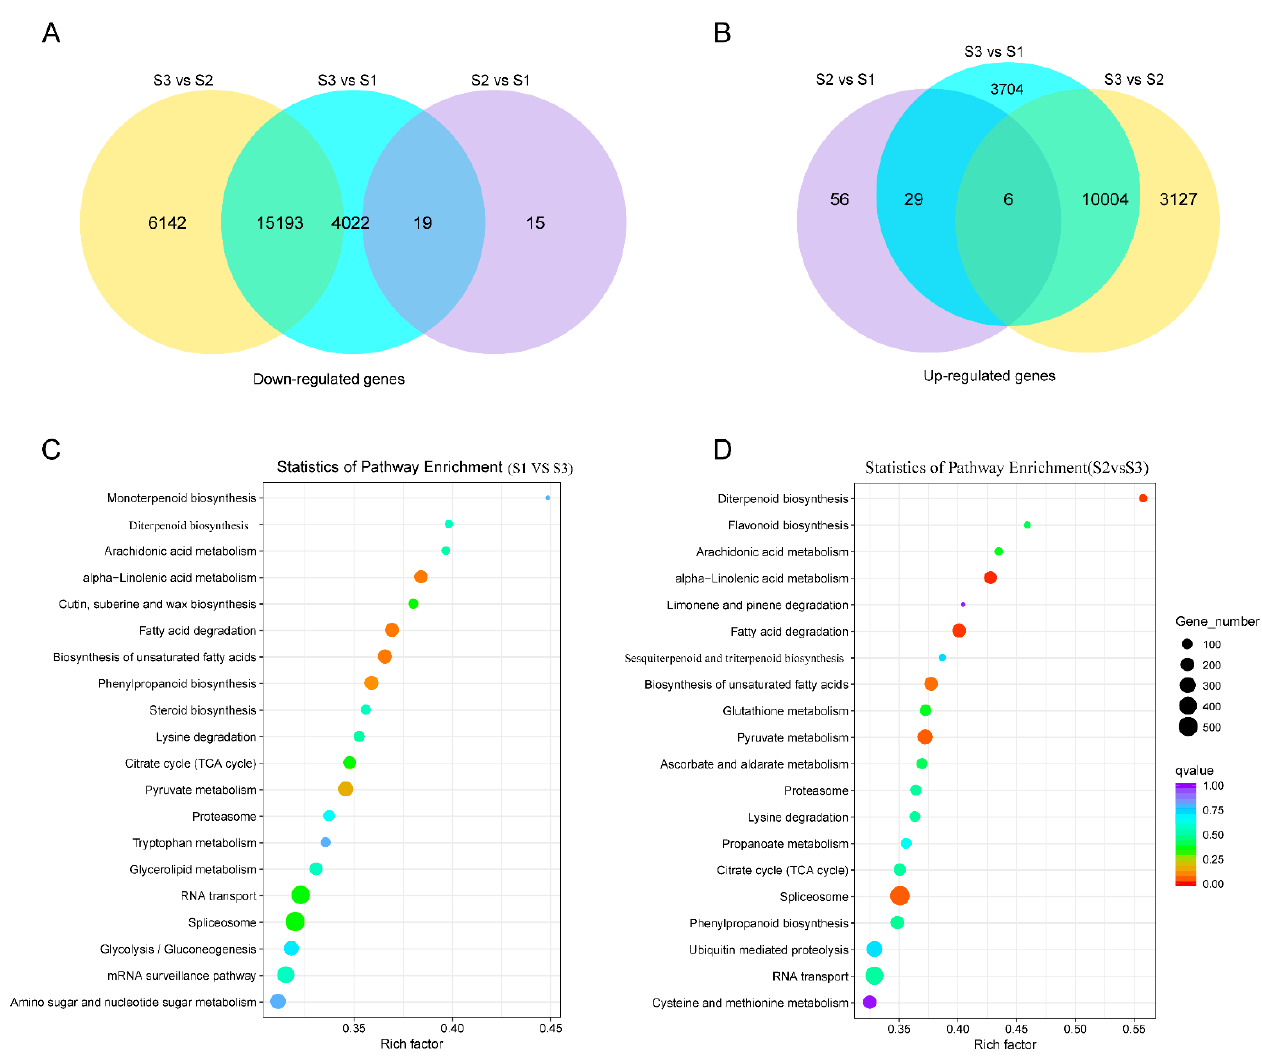
Figure 1. Differentially expressed genes in the seeding root of B. falcatum among three samples. ( A , B ) Venn diagram of all down-regulated genes and all up-regulated ones from the transcriptome. S1, the whole fresh roots of 5-day-old seedlings; S2, a 5 mm portion of root tips without the differentiation region of 15-day-old sprout; S3, differentiated root tissue of 15-day-old seedlings. ( C , D ) Pathway enrichment analysis of DEGs identified in ”S1 vs. S3” ( C ), and “S2 vs. S3” ( D ), based on the KEGG database.